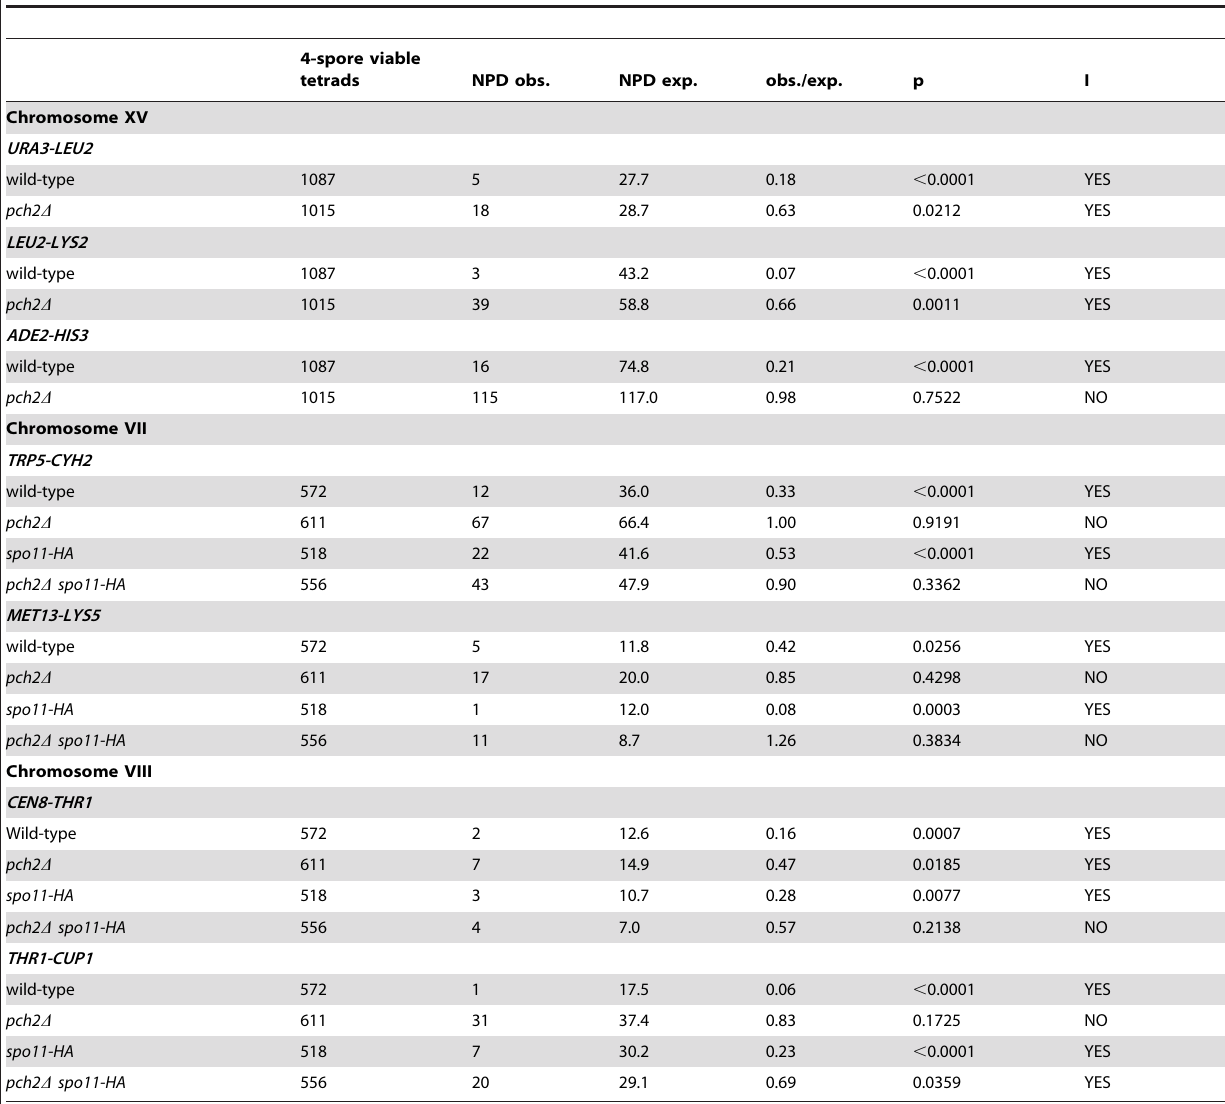
Table 4. Interference calculations using NPD